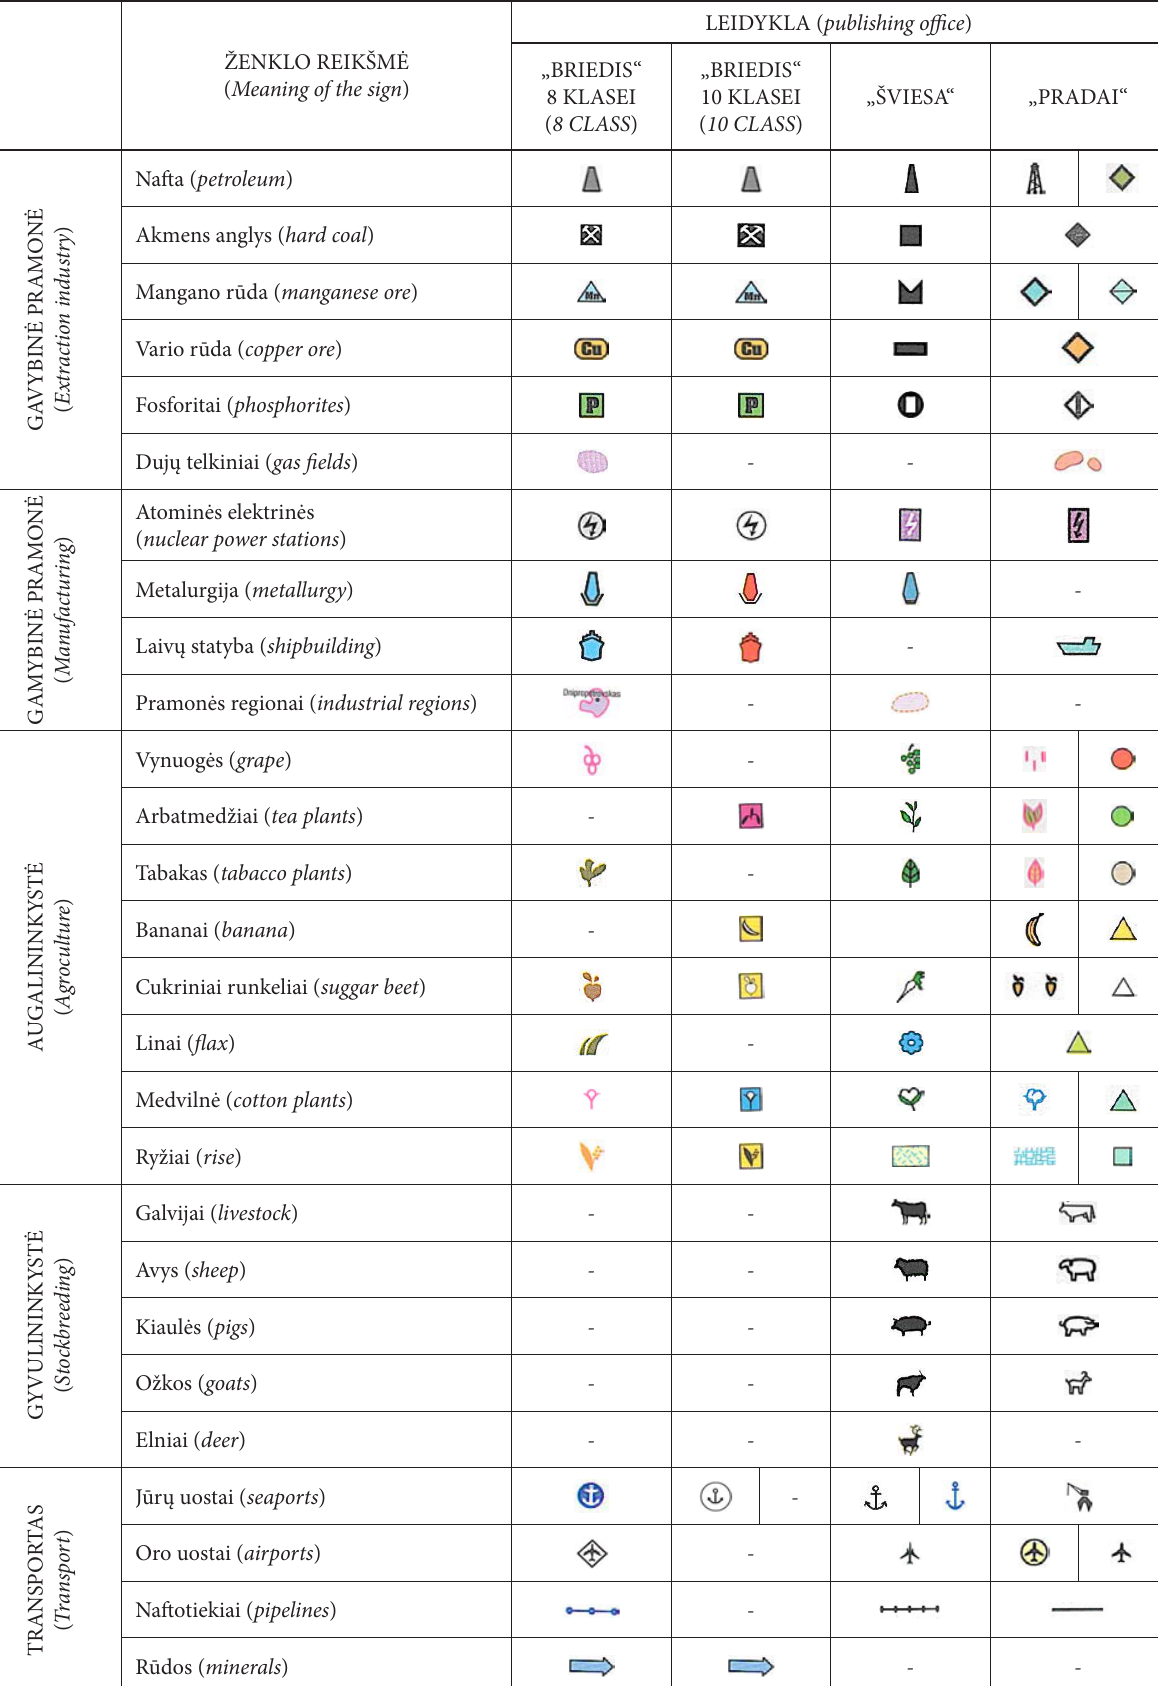
Table. A copy of notations (a part of signs) used in semiotics analysis